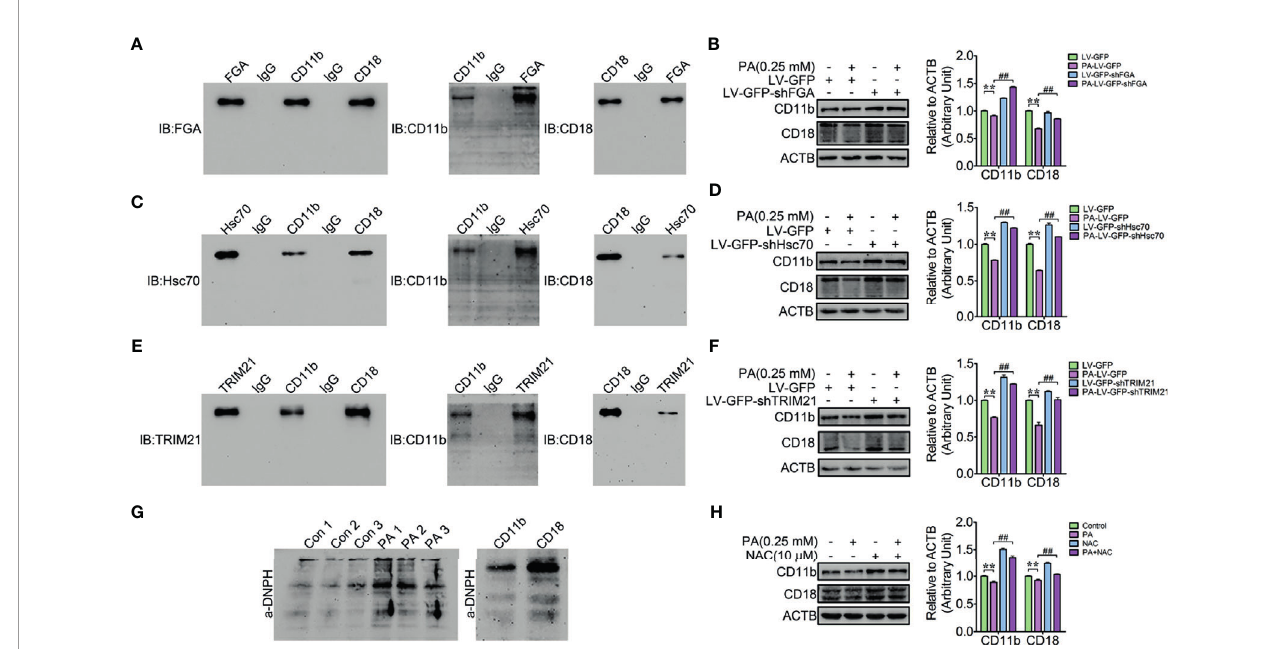
FIGURE 5 | FGA, Hsc70, and TRIM21-mediated PA induced the cytosolic oxidized CD11b and CD18 degradation. (A) Reciprocal co-IP of CD11b and CD18 with FGA in dHL-60 cells. (B) Knockdown of FGA blocked the degradation of CD11b and CD18 in dHL-60 cells ( n = 3). Data represent the mean ± s.e.m. (** p < 0.01 versus the control group, ## p < 0.01 and versus the PA-treated group; signi fi cance calculated using one-way ANOVA). (C) Reciprocal co-IP of CD11b and CD18 with Hsc70 in dHL-60 cells. (D) Knockdown of Hsc70 blocked the degradation of CD11b and CD18 in dHL-60 cells ( n = 3). Data represent the mean ± s.e.m. (** p < 0.01 versus the control group, ## p < 0.01 and versus the PA-treated group; signi fi cance calculated using one-way ANOVA). (E) Reciprocal co-IP of CD11b and CD18 with TRIM21 in dHL-60 cells. (F) Knockdown of TRIM21 blocked the degradation of CD11b and CD18 in dHL-60 cells ( n = 3). Data represent the mean ± s.e.m. (** p < 0.01 versus the control group, ## p < 0.01 and versus the PA-treated group; signi fi cance calculated using one-way ANOVA). (G) Immunoblot for the analysis of CD11b and CD18 oxidation. (H) NAC relieved PA-triggered by the degradation of CD11b and CD18. Data represent the mean ± s.e.m. (** p < 0.01 versus the control group, ## p < 0.01 and versus the PA-treated group; signi fi cance calculated using one-way